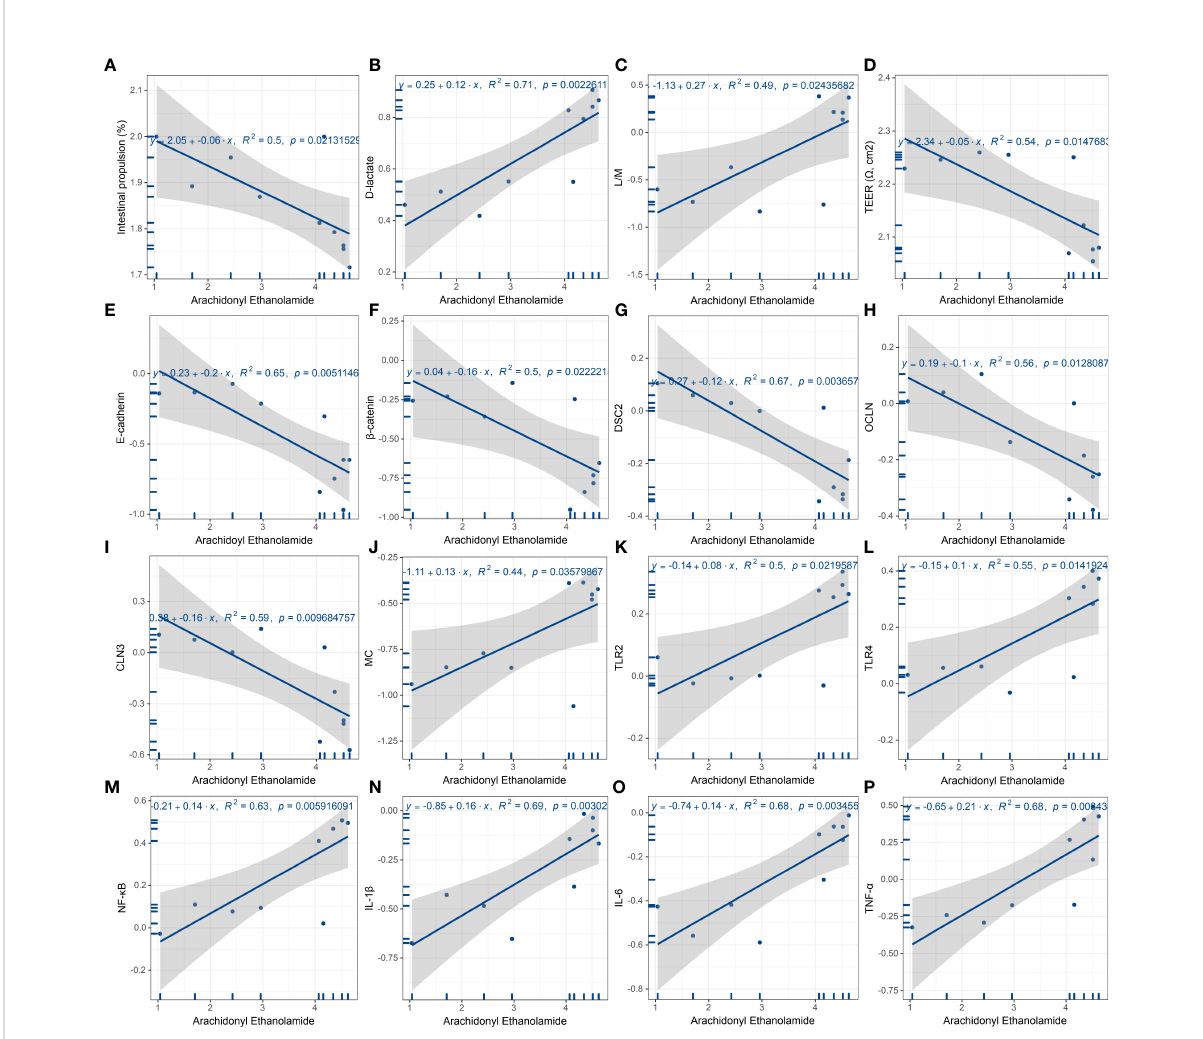
FIGURE 8 Linear regression analysis of AEA and features of FD. (A) Gastrointestinal motor function. AEA was negatively linear correlated with the gastrointestinal transit rate. (B-D) Duodenal permeability and absorption. AEA was positively linear correlated with L/M ratio (B) and the content of D-lactate (C) , while negatively linear correlated with TEER (D) . (E-I) Duodenal mucosal barrier. AEA was negatively linear corelated with the relative protein expressions of E-cadherin (E) and b -catenin (F) and the relative mRNA expressions of Dsc2 (G) , Ocln (H) and Cln3 (I) . (J-P) Innate immune cells and proin fl ammatory signaling. AEA was positively linear correlated with the relative amounts of mast cells (J) , the relative mRNA expressions of Tlr2 (K) , Tlr4 (L) and Rela (M) , and the contents of proin fl ammatory cytokines IL-1 b (N) , IL-6 (O) and TNF- a (P) (All data are log10 transformed. p < 0.05 represent signi fi cant) ( n = 5